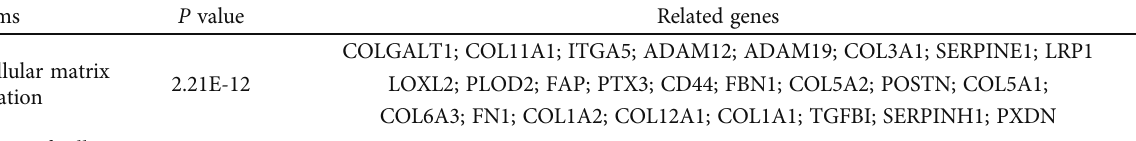
Table 4: GO analysis of FXYD2 in the TCGA cohort.